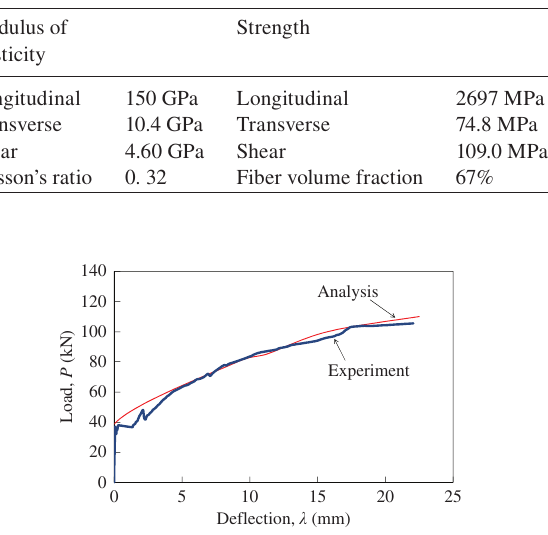
Table 2 Material properties of CFRP.